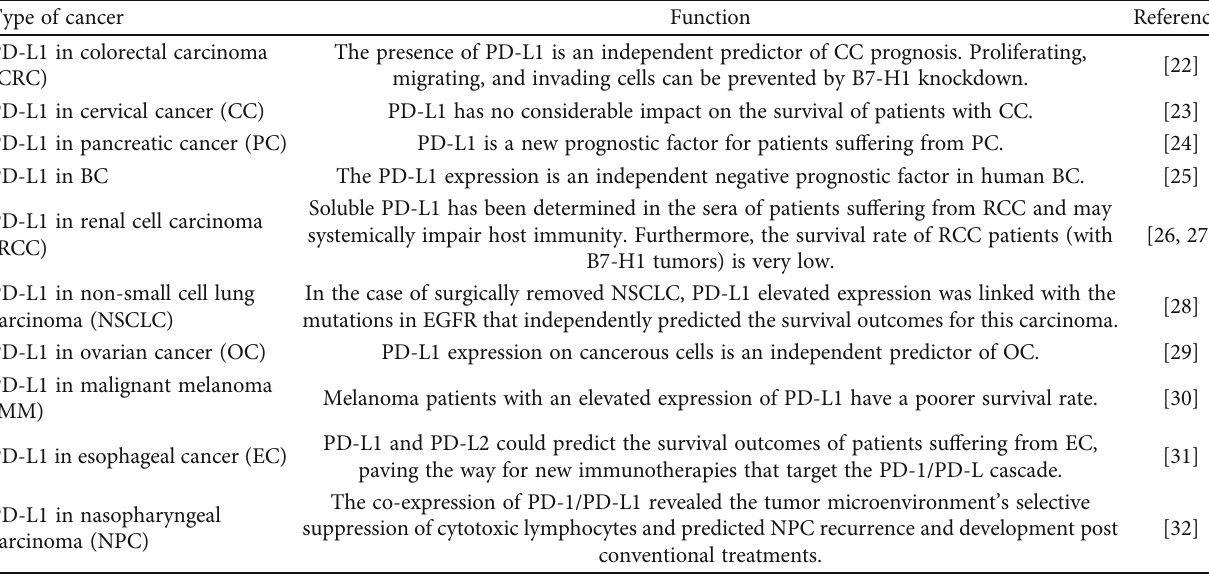
Table 1: PD-L1 correlation in di ff erent carcinomas and its functions.